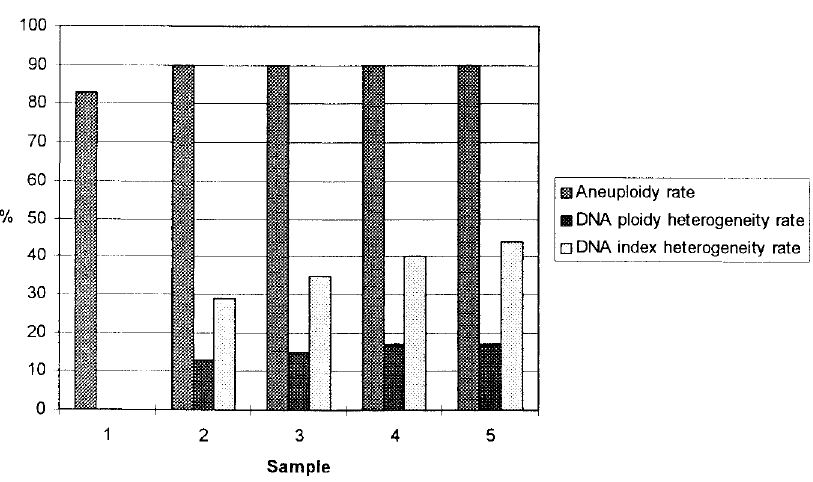
Fig. 3. Cumulative aneuploidy rate, DNA ploidy heterogeneity rate and DNA index heterogeneity rate after analysis of 1–5 samples. 9.6%, median of 8.4% and a range of 0.3–37.1%.